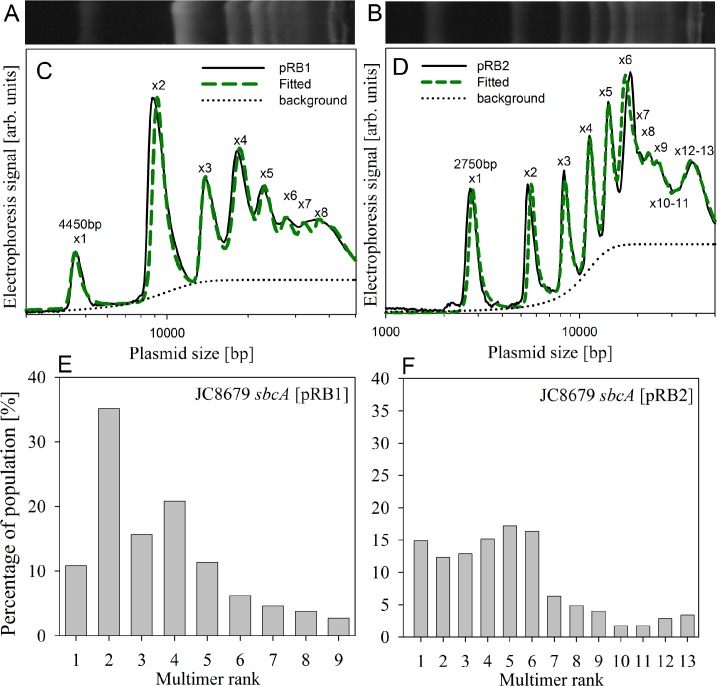
Densitometric evaluation of the multimer pattern of pRB1 and pRB2 isolated from hyper-recombinogenic E. coli JC8679 sbcA (generation “0”).Panels A and B show agarose gel electrophoresis of plasmid multimers for pRB1 and pRB2, respectively. Panels C and D show multimer forms determined by densitometry scanning. The dashed green line was calculated assuming that the observed pattern represents different types of plasmid multimers (×1- monomers, ×2- dimers, ×3- trimers, etc., as given by Eq 14). Panels E and F show distribution of pRB1 and pRB2 plasmid multimers.